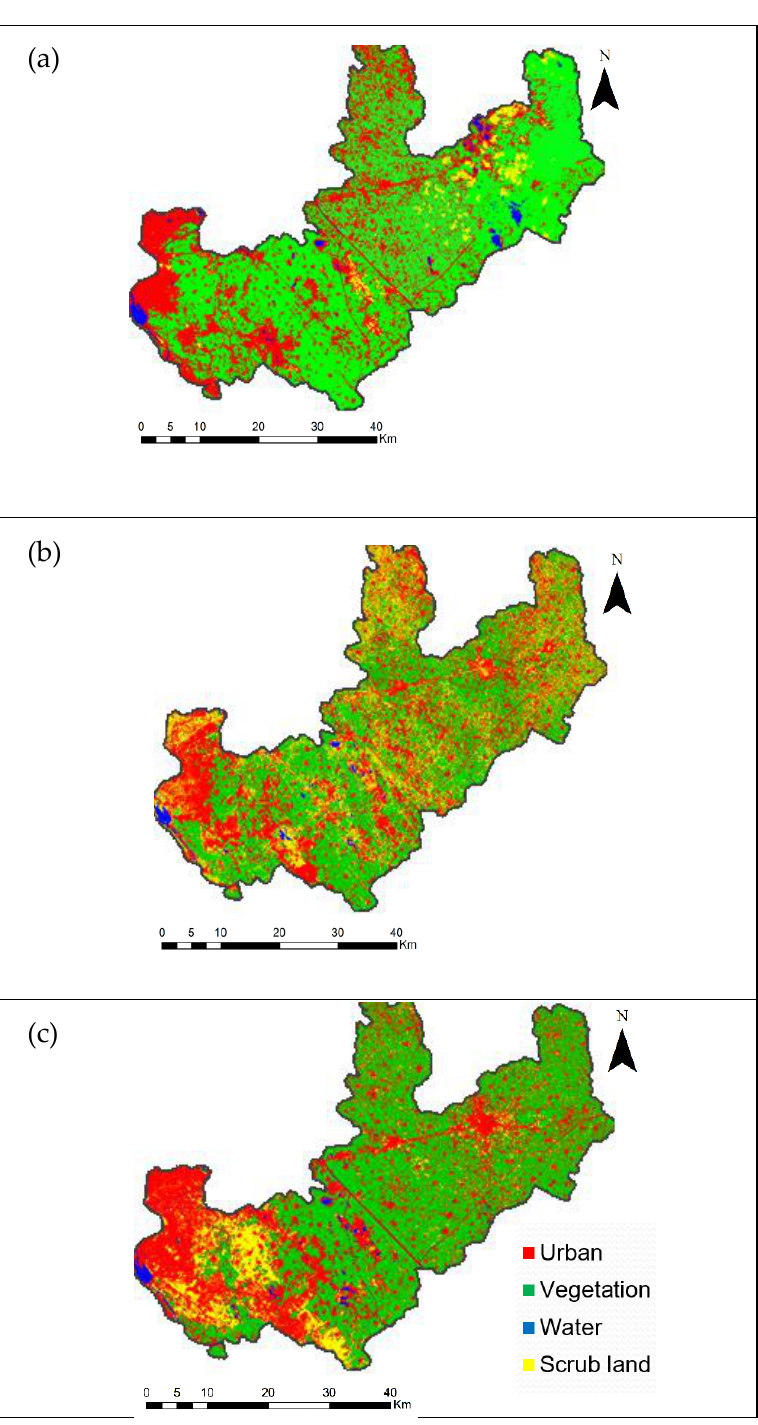
Figure 6. Land Use Land Cover (LULC) maps with the spatial distribution of various classes for the year ( a ) 1989, ( b ) 2000, and ( c ) 2011.